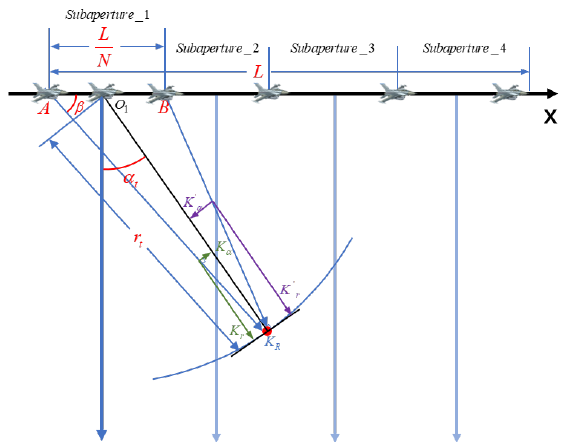
Figure 1. Rules for coordinate system establishment in FBP